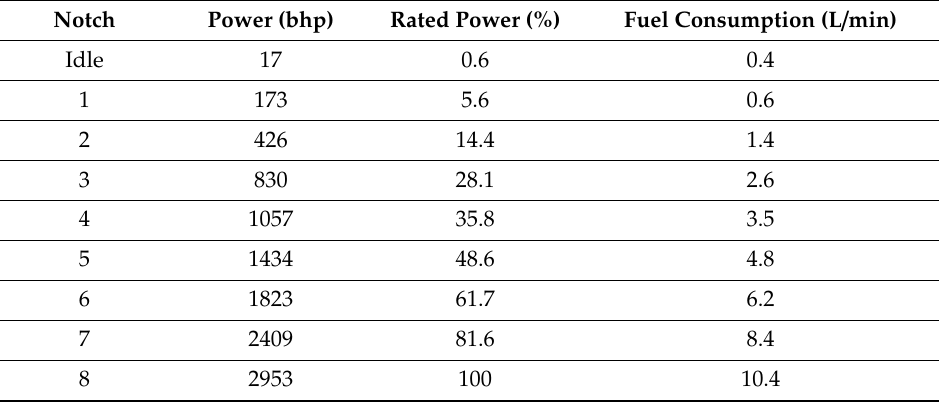
Table 2. Characteristics of the diesel locomotive engine power and fuel consumption. Notch Power (bhp) Rated Power (%) Fuel Consumption (L /